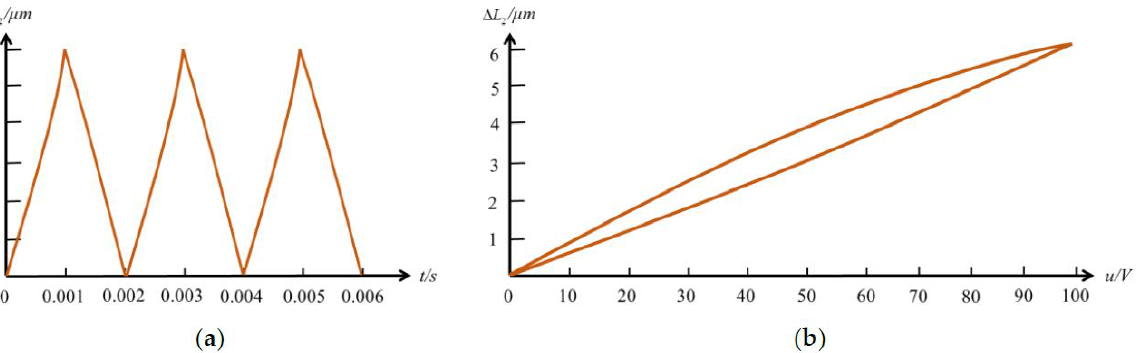
Figure 7. The test result of the extension of the proposed actuator. ( a ) The relationship between ∆ L 2 and time; ( b ) the relationship between ∆ L 2 and input voltage.